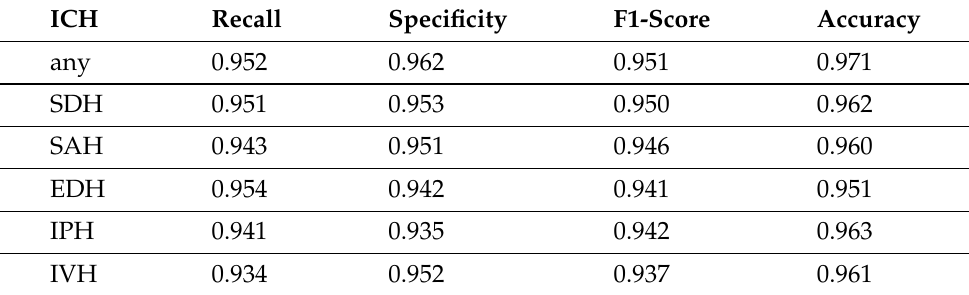
Table 3. Evaluation results of Res-Inc-LGBM for ICH detection using CQ500